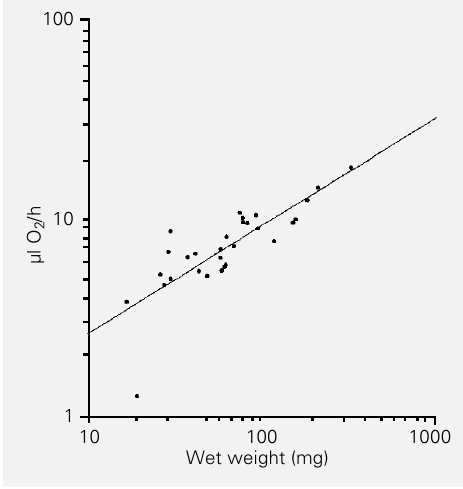
Figure 1 - Regression line of oxy- gen consumption vs log body mass in Glossobalanus